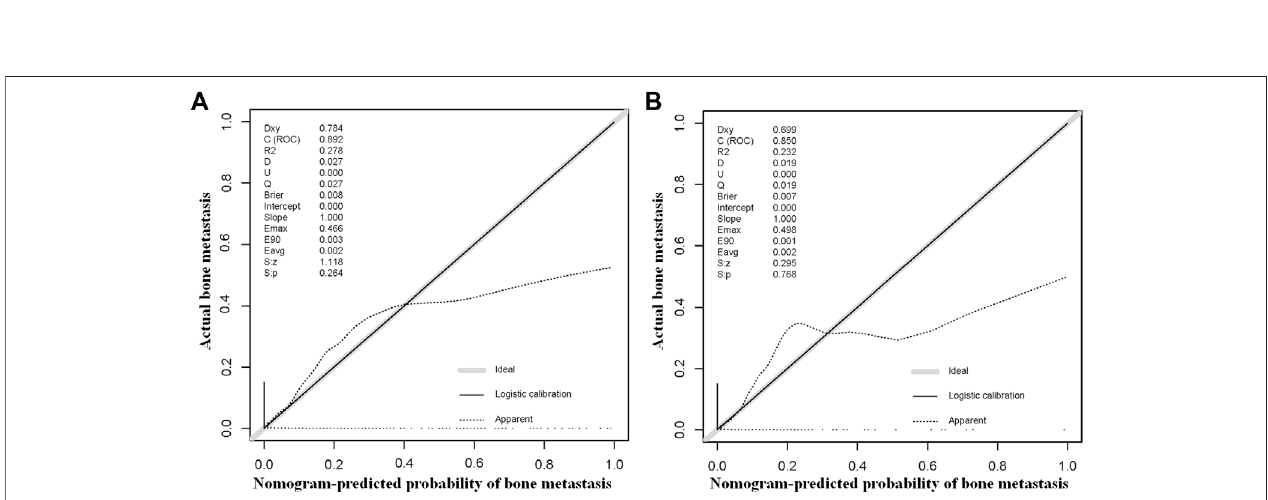
FIGURE 2 | The training and the validation sets ’ calibration curves of the constructed nomogram in our study were used to predict the risk of bone metastasis in head and neck cancer patients. Grey line denotes ideal; black line logistic calibration; dotted line apparent.